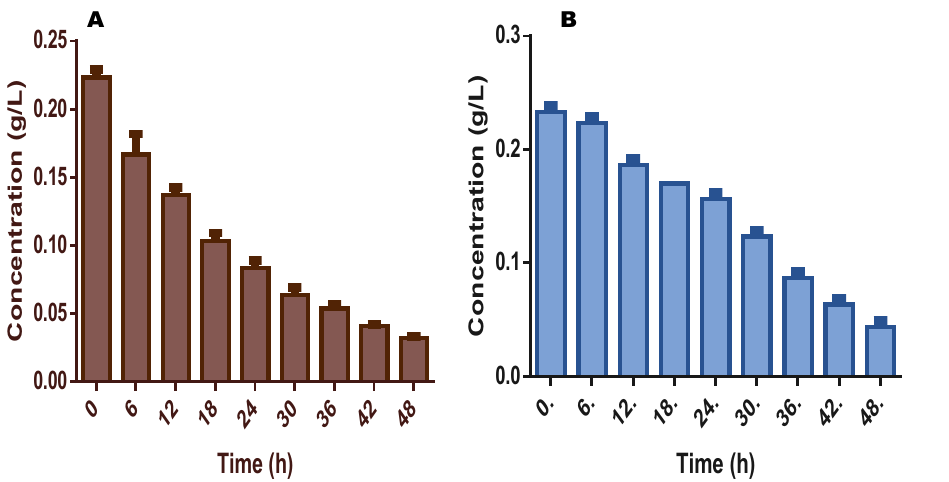
Time (h) Figure 5. This figure shows the pattern of total nitrogen (TN) conversion for ( A ) food wastes and ( B ) spent animal beddings during the